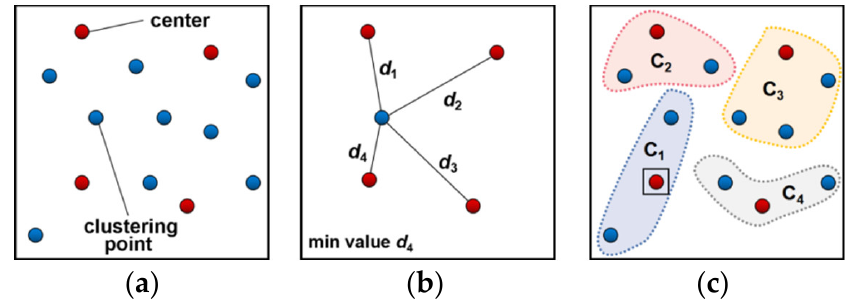
Figure 3 is an example for Algorithm 2. Four centers (red points) are chosen; see Figure 3a. For one point out of the center (blue point), calculate the value d between the blue point and all the red points and determine the minimum value; see Figure 3b. The blue point with the minimum value belongs to the red point cluster (with square); see Figure 3c. Perform the process on all the blue points and determine which blue point belongs to which red point cluster.